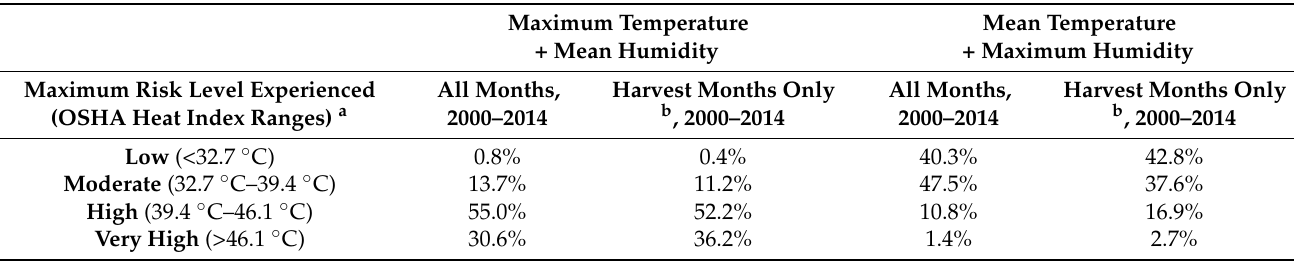
Table 3. Percentage of days meeting criteria for U.S. Occupational Safety and Health Administration heat index-based risk levels at ISA, 2000–2014.